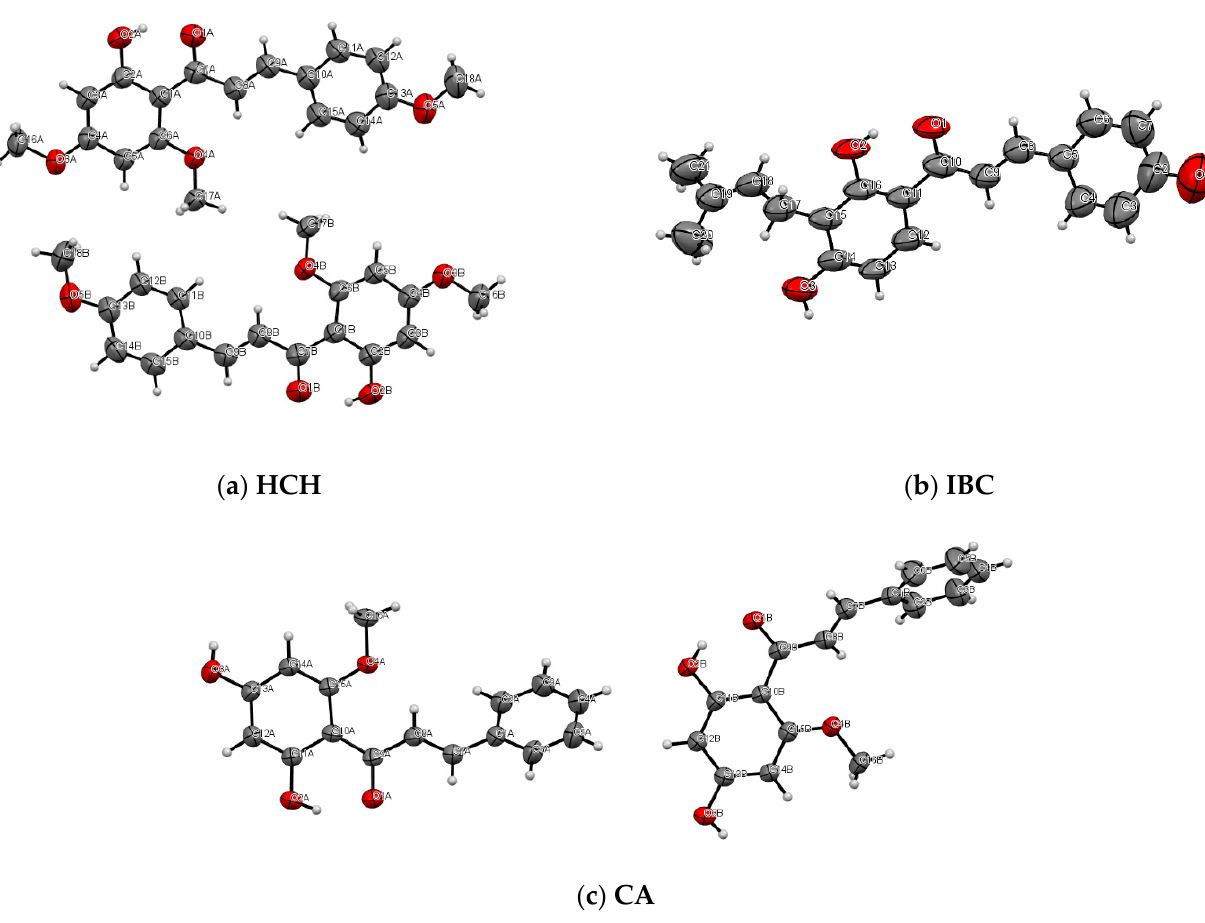
Figure 7. ORTEP representation of the asymmetric unit of HCH ( a ), IBC ( b ) and CA ( c ), showing the non-hydrogen atom-numbering scheme. Displacement ellipsoids are drawn at the 50% probability level.